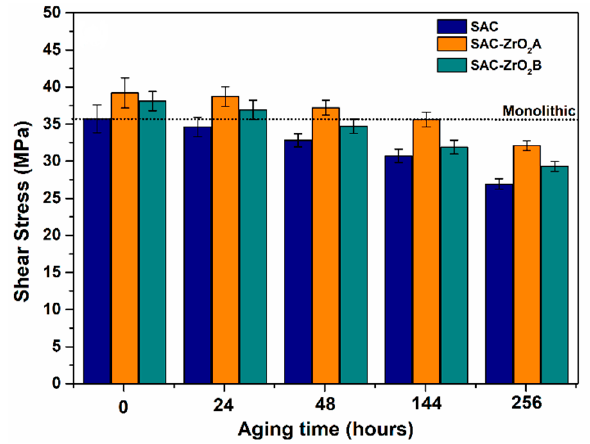
Figure 7. Shear strength of SAC 305/Cu, SAC 305-ZrO 2 A/Cu and SAC 305-ZrO 2 B/Cu joints in as-reflowed and in 175 °C isothermal aged condition .